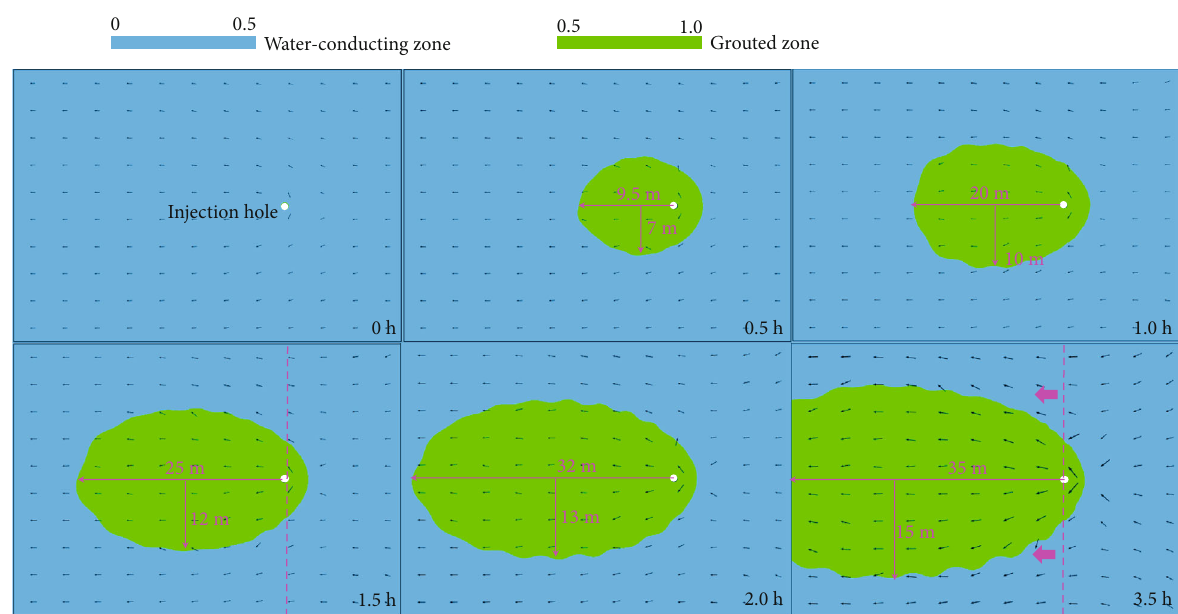
Figure 7: Di ff usion boundary tracking from volume